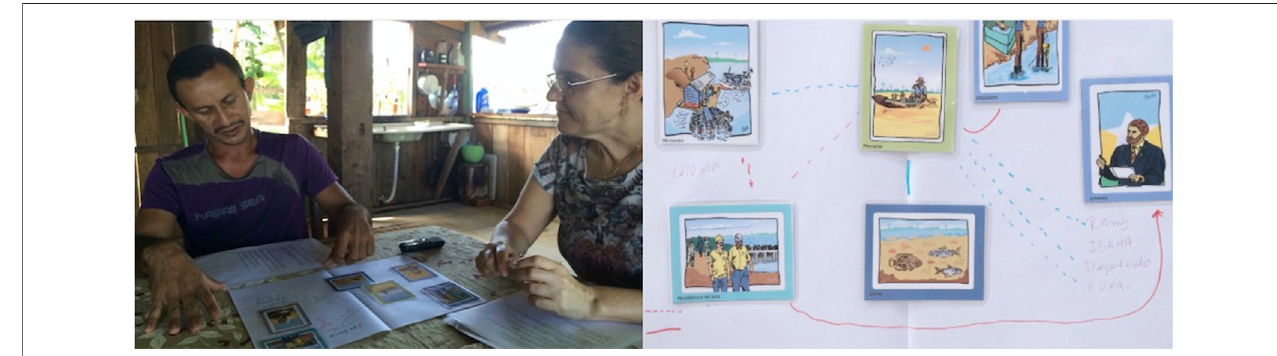
FIGURE 3 | Drawing of the perception of actors about the Madeira Fisheries System and a picture of the interview. The continuous blue link here represents the strong relation and the dashed red link represent the weak relation.